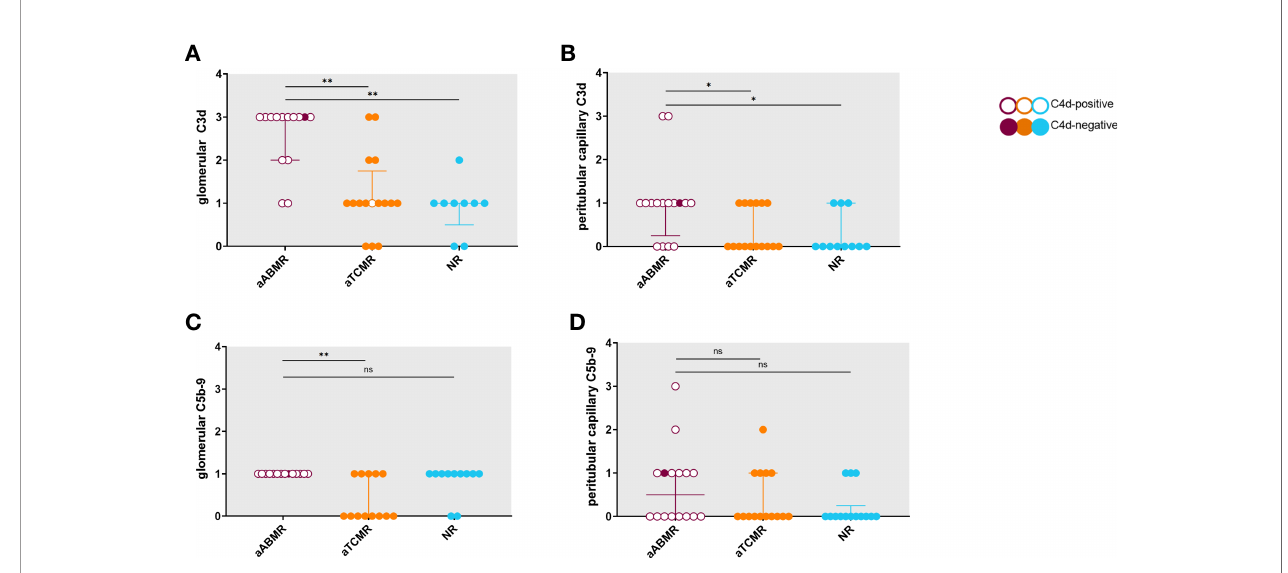
FIGURE 3 | Semiquantitative scores for C3d and C5b-9 deposition in renal biopsy specimens of aABMR, aTCMR, and NR patients. Semiquantitative scores range from 0 to 4, with higher scores indicating increased positivity in biopsy. Groups are compared regarding glomerular C3d deposition (A) , peritubular capillary C3d (B) , glomerular C5b-9 (C) , and peritubular capillary C5b-9 (D) deposition. Data represent staining results of individual patients. Error bars represent median with interquartile range. Un fi lled circles symbolize biopsies of C4d-positive patients, fi lled circles C4d-negative patients. P-values are derived from Mann-Whitney U tests